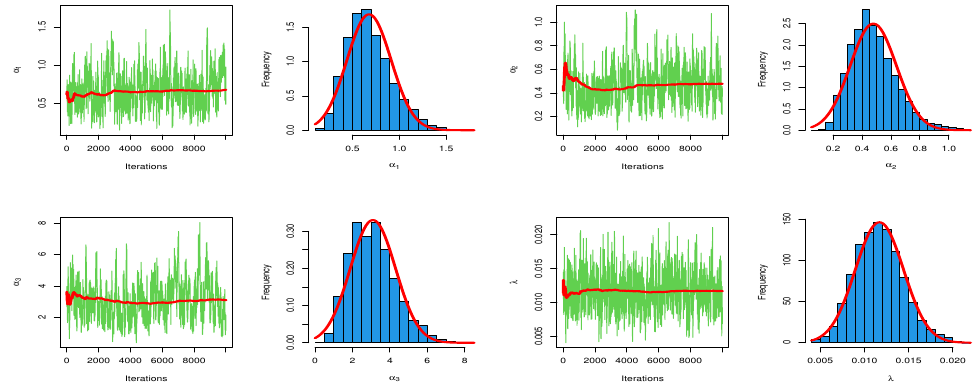
Figure 7. Trace and normal curve of posterior distribution for MCMC estimation of stress–strength for EED based on complete